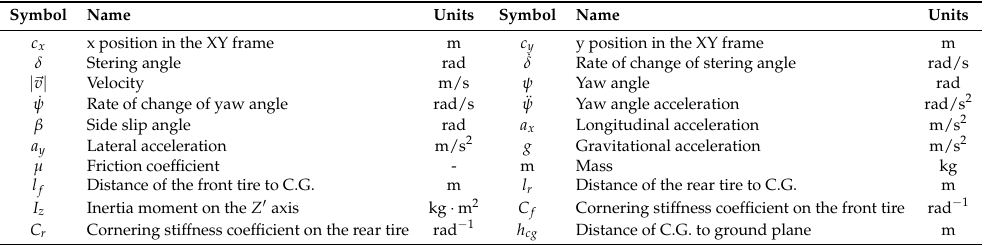
Table 1. Nomenclature for the ST vehicle